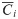
Achieving TCOs in motif C.(a) Averaged control coefficient C¯i over the examined temperature range for different parameter combinations. The error bar is the standard deviation. The horizontal axis is the index for circuits with different TCO parameters for motif C. The decay rate constant r2 has the largest amplitude and dominates the oscillation period. The data were obtained by computations of 100,000 parameter samplings. (b) The activation energies for the rate constants corresponding to the control coefficients in (a). The activation energies for r2 fall primarily on the bottom. (c) is the product Ci¯Ei of the data in (a) and (b).